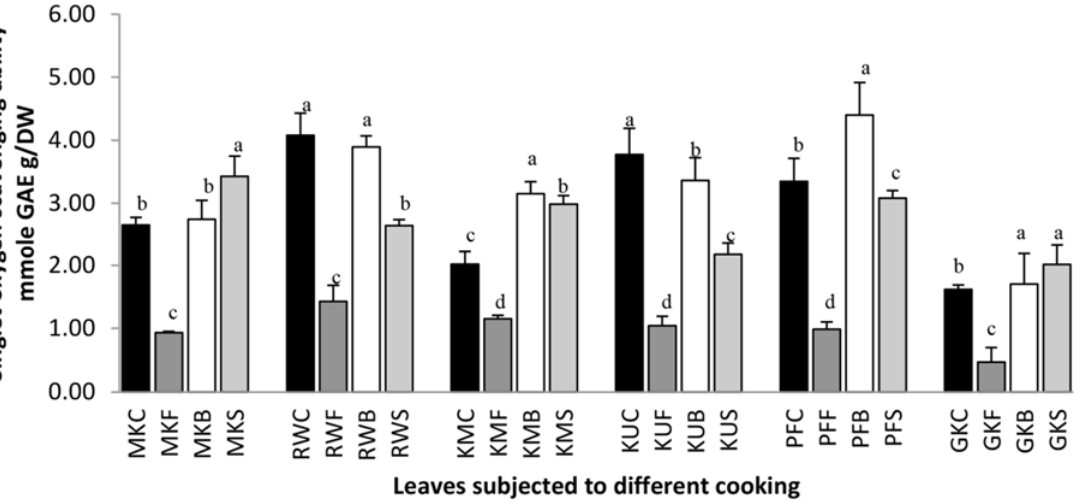
Figure 6. Singlet oxygen scavenging ability of raw and cooked extracts of some green leafy vegetables. Values represent the means of triplicate readings. MK, O. zeylanica ; RW, C. auriculata ; KM, S. grandiflora ; KU, G. lactiferum ; PF, P. edulis ; GK, C. asiatica . C—fresh leaves; F—fried; B—boiled; S—steamed. Data are means ± standard deviations of three replicate determinations. Columns with different letters for each vegetable are significantly different ( p < 0.05).